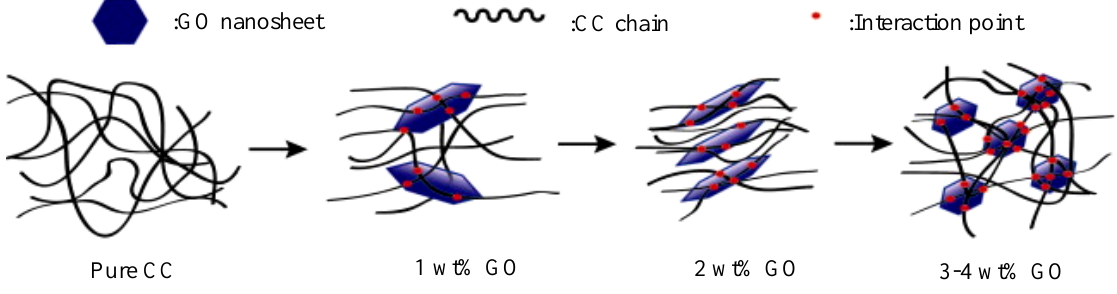
Figure 6. Schematic descriptions of the microstructure of 5 wt% CC solutions containing different contents of GO. Reprinted with permission by Elsevier [87].